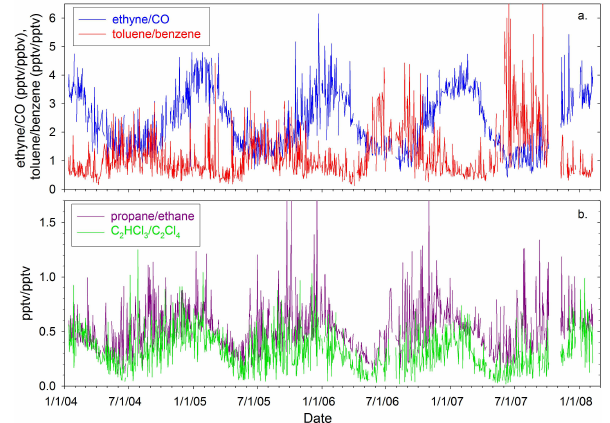
Fig. 10. Time series of the (a) ethyne/CO (pptv/ppbv) and toluene/benzene ratios and (b) propane/ethane and C 2 HCl 3 /C 2 Cl 4 ratios during January 2004–February